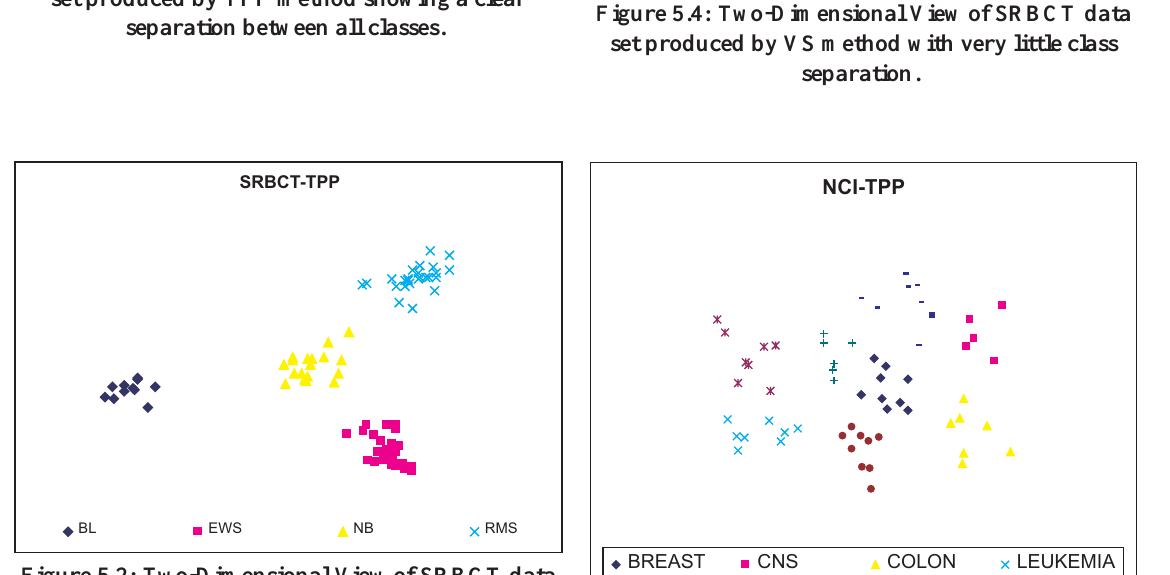
Figure 5.2: Two-Dimensional View of SRBCT data set produced by TPP method, showing clear separation between all clasess.